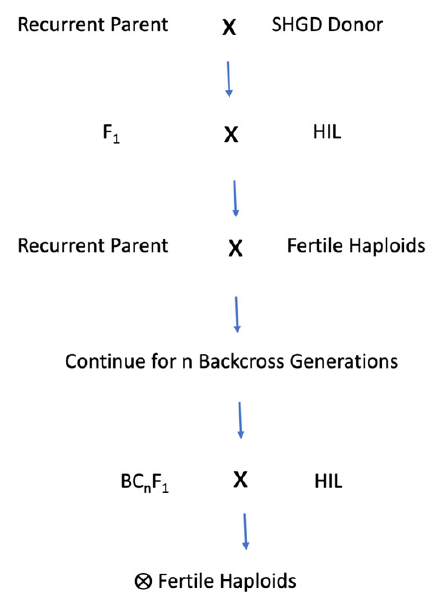
Figure 4. Schematic for phenotypic backcross introgression of SHGD into non-SHGD germplasm, resulting in DH lines possessing SHGD.